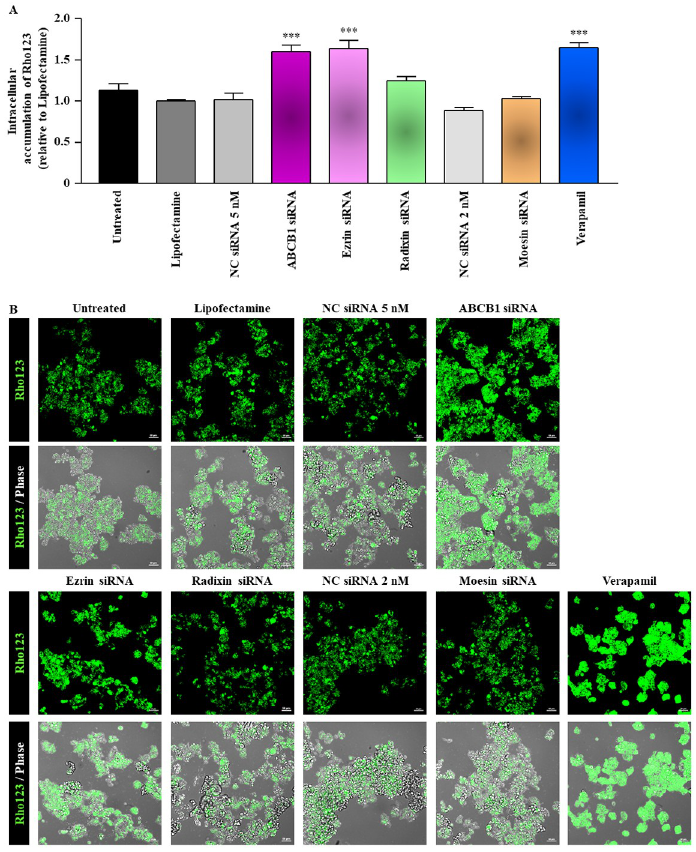
Fig 6. Intracellular accumulation of Rho123 in LS180 cells after treatment with siRNA. Cells were treated with the transfection medium (Untreated), transfection reagent (Lipofectamine), nontargeting control (NC) siRNA, and specific siRNAs for ABCB1, ezrin, radixin, or moesin and then incubated for 3 days. (A) The intracellular accumulation rate of Rhodamine (Rho) 123 normalized to the total protein amount (pmol/ μ g protein) relative to the accumulation in cells treated with the transfection reagent alone. n = 6, ��� p < 0.001 vs. Lipofectamine. Data are expressed as the mean ± SEM and were analyzed by one-way ANOVA followed by Tukey’s test. (B) Representative confocal laser scanning microscopy images of fluorescent Rho123 and of each overlay with phase contrast in LS180 cells. Upper and lower panels indicate Rho123 and merge of Rho123 with phase contrast image, respectively. Scale bars: 50 μ m. All the images are representative of at least three independent